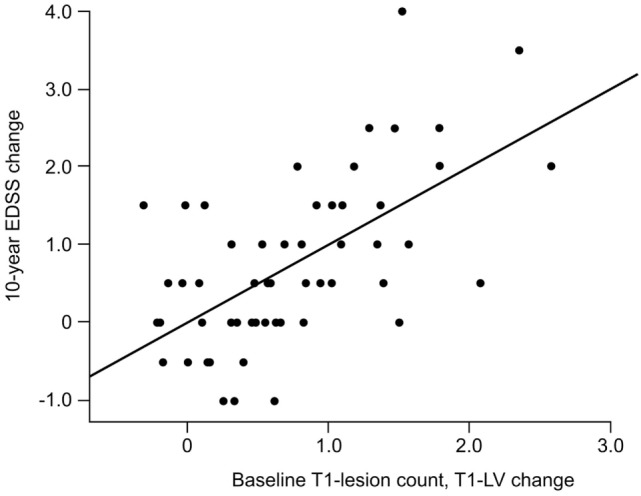
Correlation between the 10-year change in EDSS and the combined measure of baseline T1-hypointense lesion count and 10-year T1-hypointense lesion volume change (r = 0.61; p < 0.001). Reprinted from (66) by Permission of SAGE Publications, Ltd. Copyright © 2014 The authors of the original work.